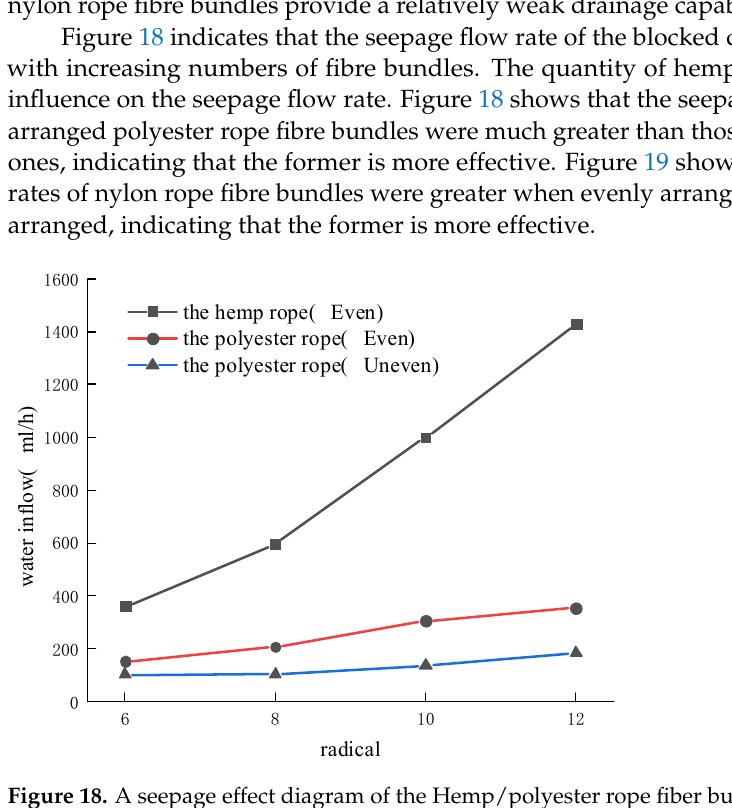
Figure 19. A seepage effect diagram of the nylon rope fiber bundle. 6